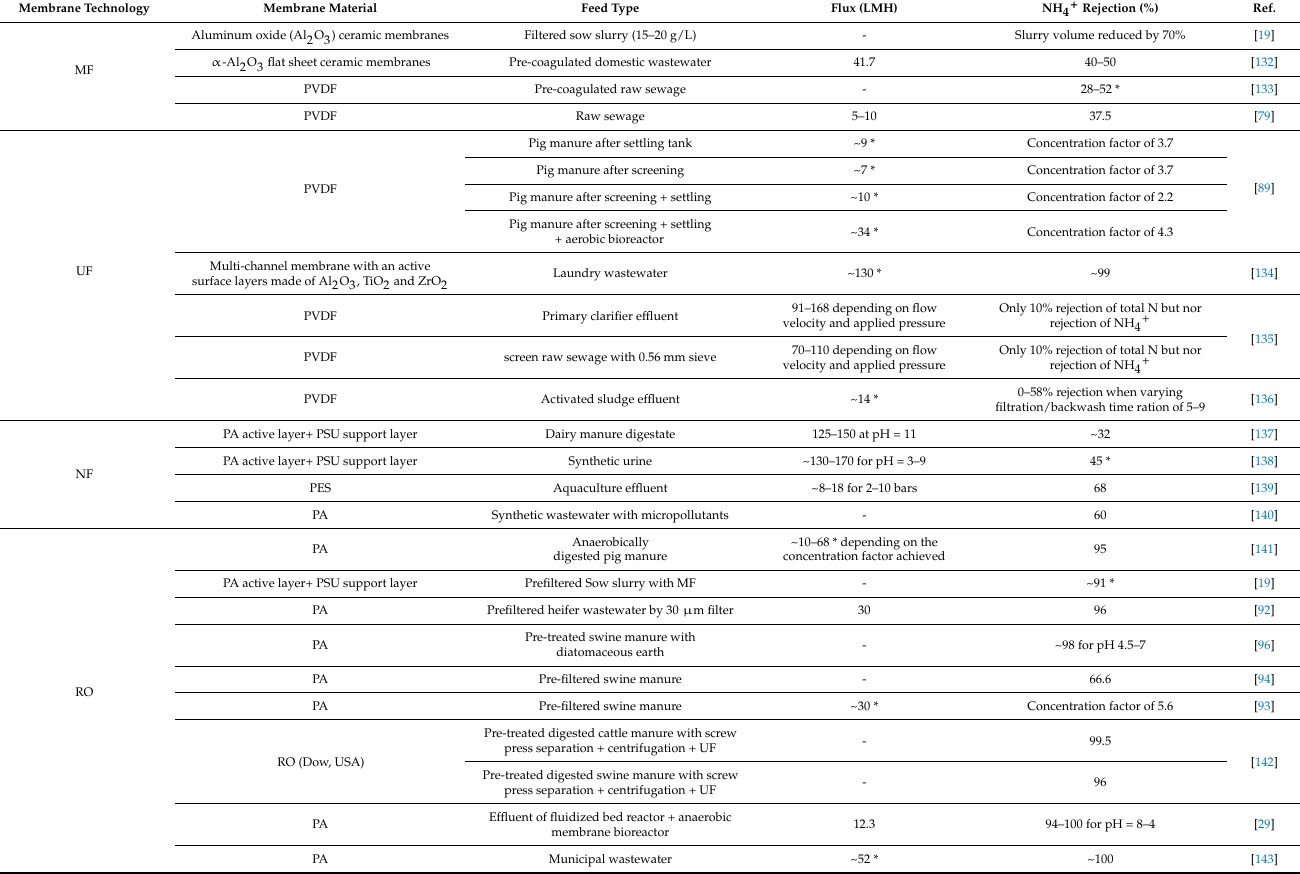
Table 3. Summary of nitrogen recovery with pressure-driven